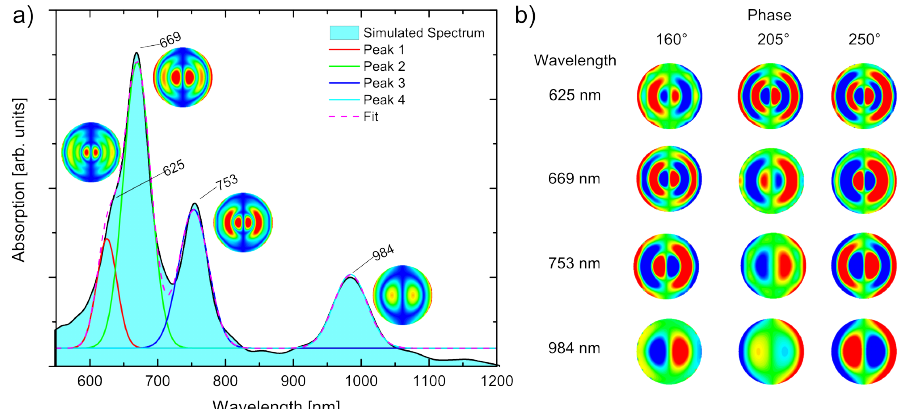
Figure 4. Excitation of surface modes in a gold-silica-silver sandwich. ( a ) The absorption spectrum with the time averaged electric near field of monochromatic excitation; ( b ) shows the evolution of the electric near field at different phase